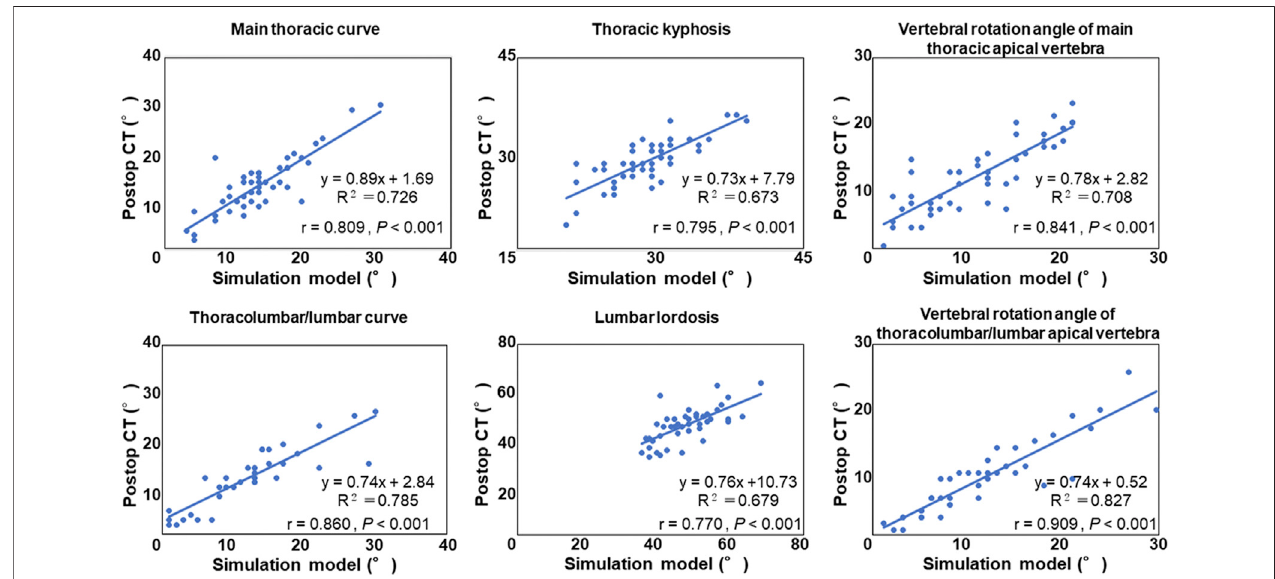
FIGURE 3 | Correlation analysis between the postoperative computed tomography (CT) measurement and the simulation model.